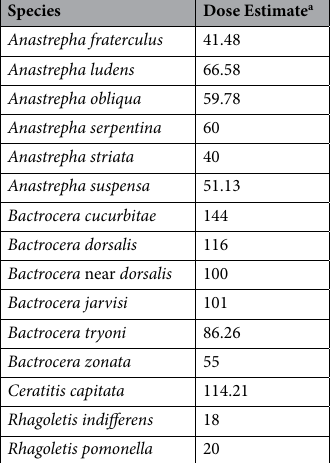
Table 3. Sterilizing doses from Tephritidae literature review. Data from multiple studies are combined for each species. End point was prevention of emergence of normal-looking adults. a Estimate taken as the geometric mean of reported doses, with the maximum dose set as the lowest dose where the confidence in 99.99% efficacy was > 0.99.